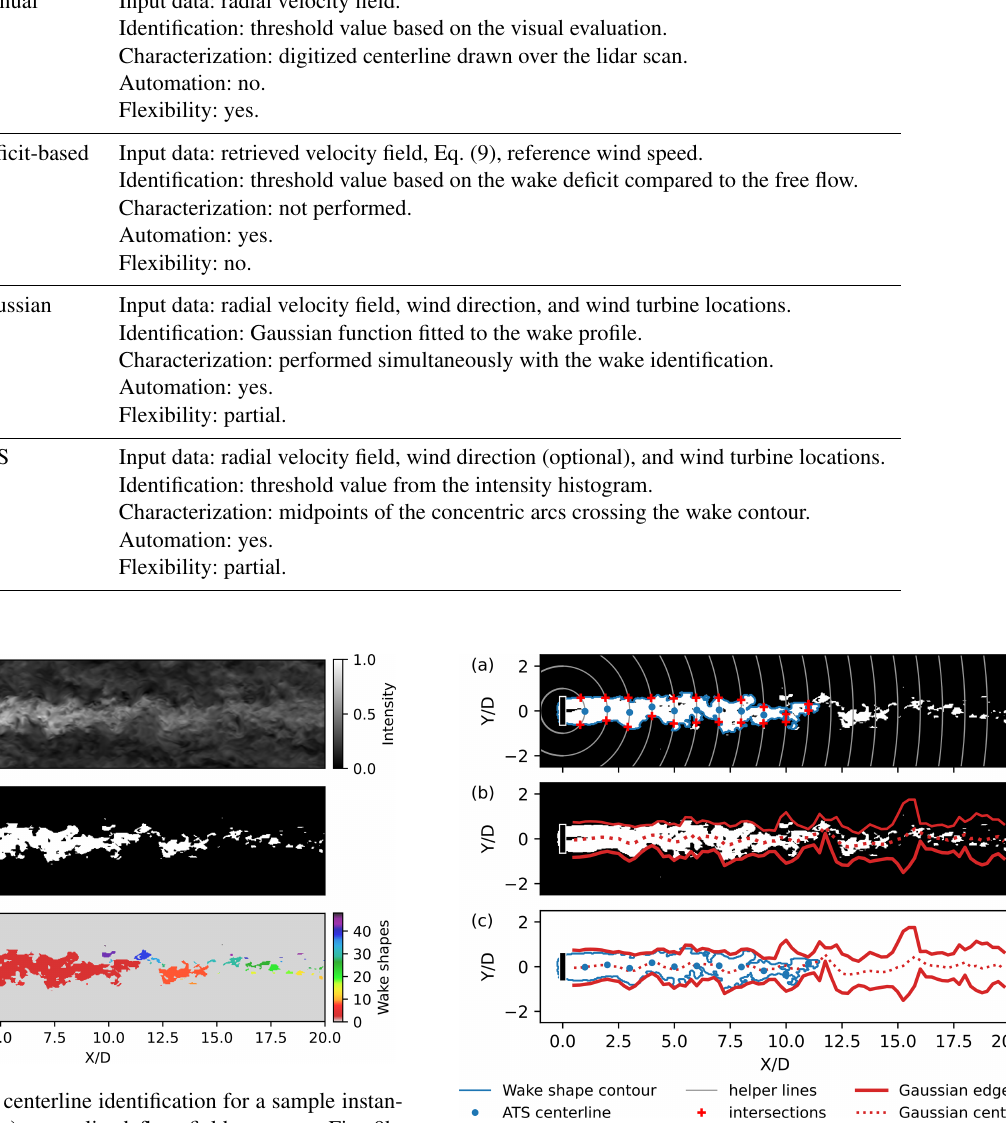
Figure 13. Sample wake identification and characterization using idealized LES data. (a) Thresholded data overlaid with the contour of the wake shape; (b) thresholded data overlaid with the wake boundaries and centerline detected by the Gaussian method; and (c) ATS and Gaussian wake detection results,